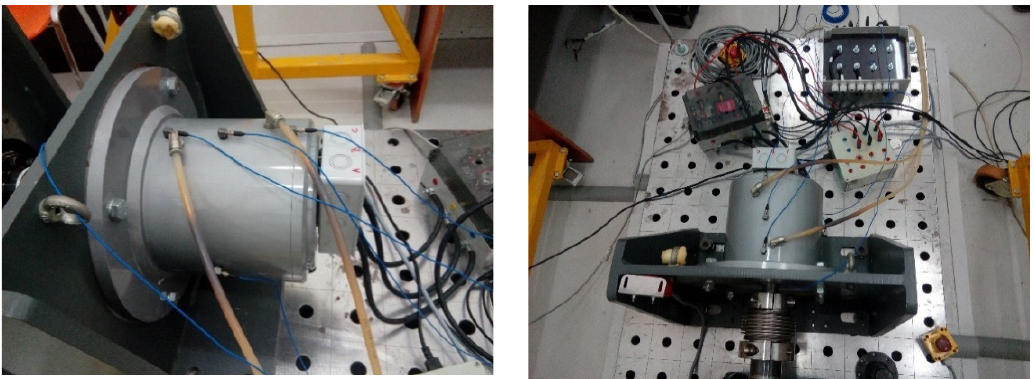
Figure 9. Vibration sensors’ placement and water-cooling connection .